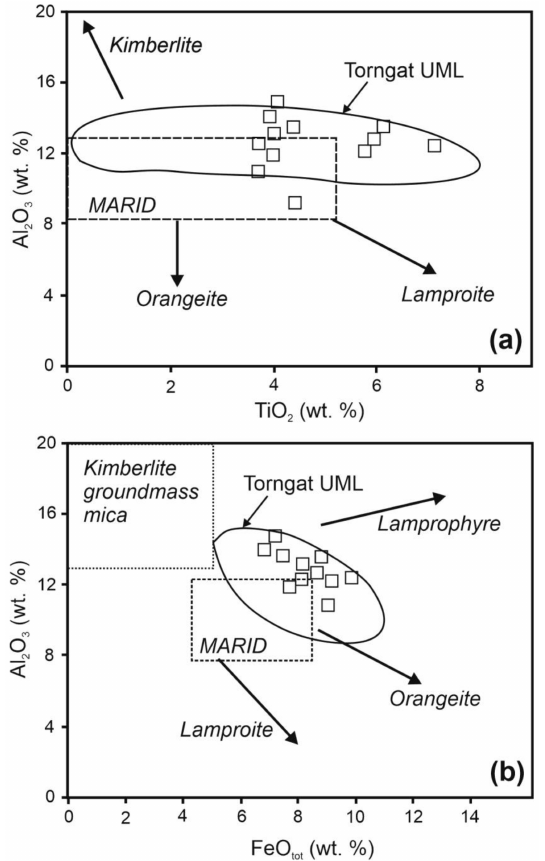
Figure 10. Compositional variations of phlogopite from the Vinoren rock in the diagrams ( a ) TiO 2 vs. Al 2 O 3 and ( b ) FeO tot vs. Al 2 O 3 (squares). Compositional fields and evolutionary trends of phlogopite from kimberlites, orangeites, lamproites and lamprophyres are after [50]. MARID (mica-amphibole-rutile-ilmenite-diopside) compositional field is after [40] and [51]. Phlogopite compositions from Torngat ultramafic lamprophyres (UML) are from